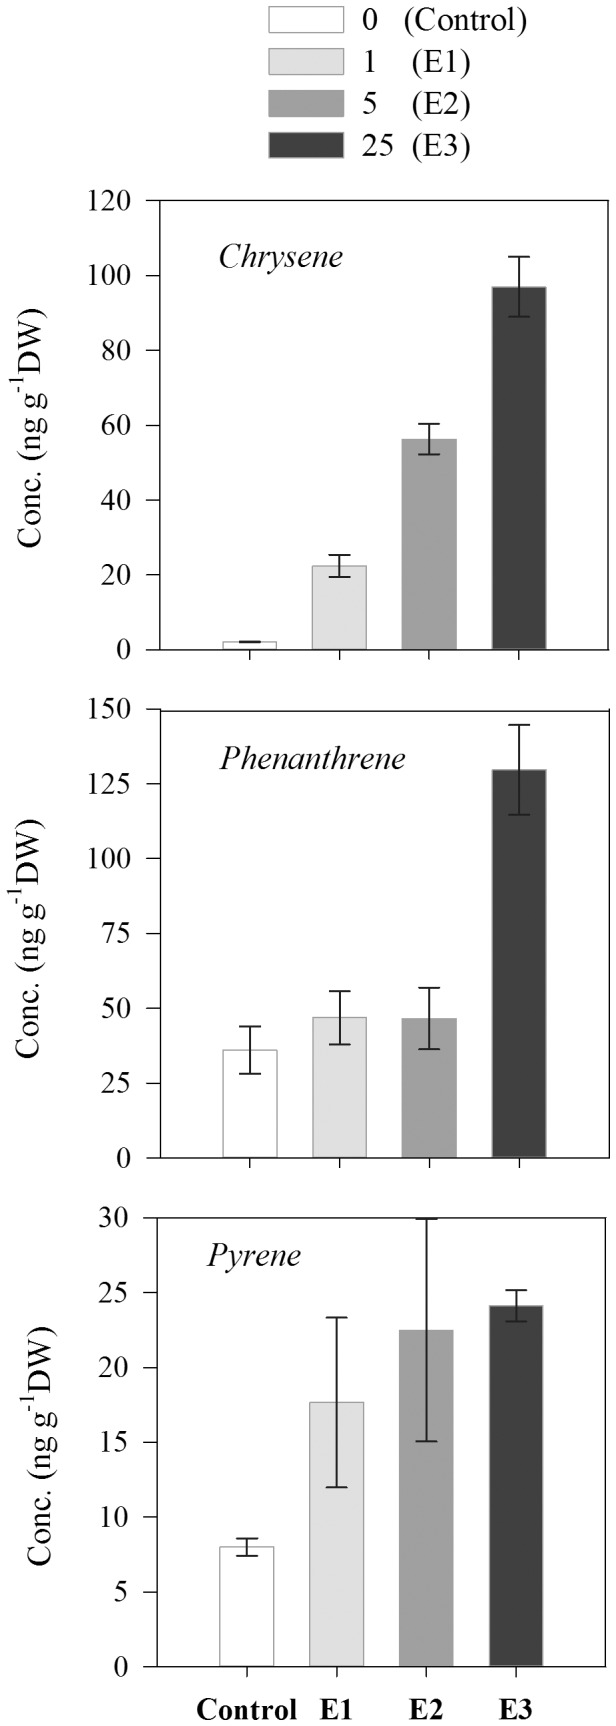
Concentration of the main polycyclic aromatic hydrocarbons detected in adult stages of scyphozoan Aurelia aurita after 6 days of exposure to different crude oil concentrations.(Control: no oil, E1: 1 µL L−1, E2: 5 µL L−1, E3: 25 µL L−1.) Error bars represent the standard errors.